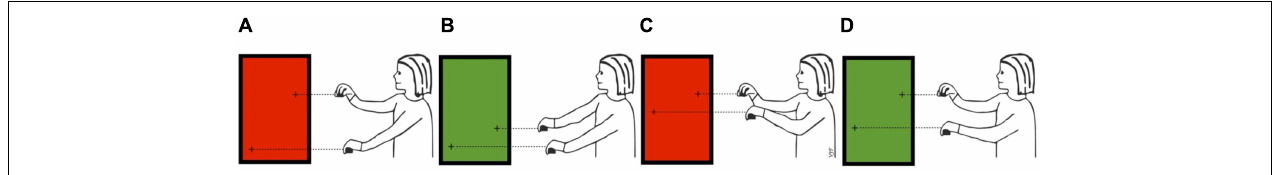
FIGURE 2 | The Mathematics Imagery Trainer for Proportion: schematic activity sequence (Art credit: Virginia J. Flood). (A) while exploring, the student first positions the hands incorrectly (red feedback); (B) stumbles upon a correct position (green); (C) raises the hands, maintaining a fixed interval between them (red); and (D) corrects the position (green). Note in B and D the different spatial intervals between the cursors or hands.